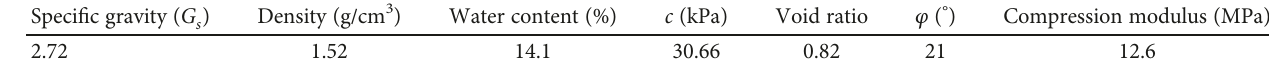
Table 1: Parameters of undisturbed